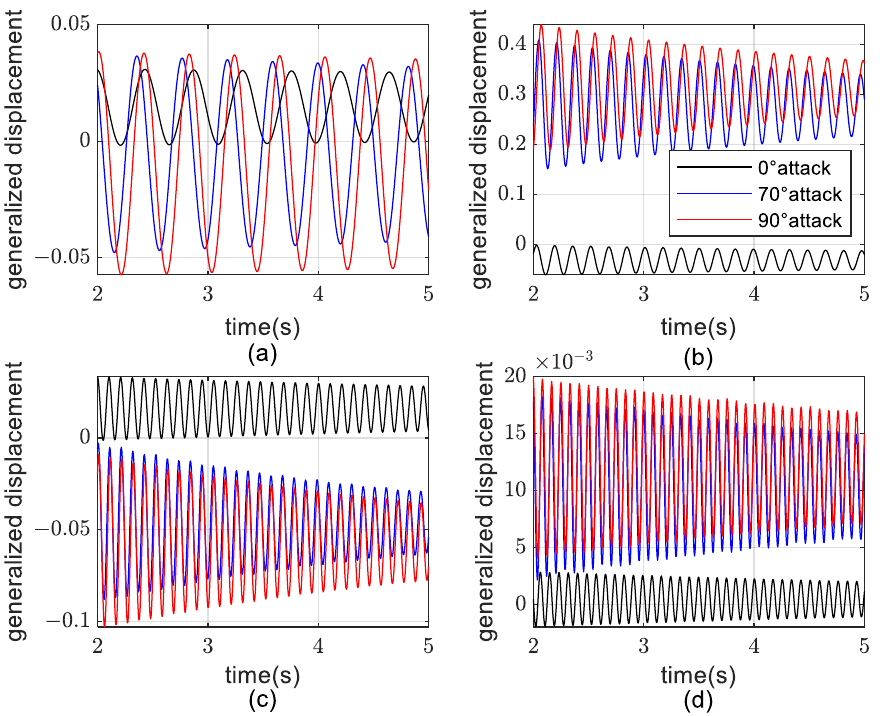
Figure 10. Curves of the generalized displacement–time response ( Ma = 0.5, p = 700 Pa). ( a ) First- order mode, ( b ) second-order mode, ( c ) third-order mode, and ( d ) fourth-order mode.